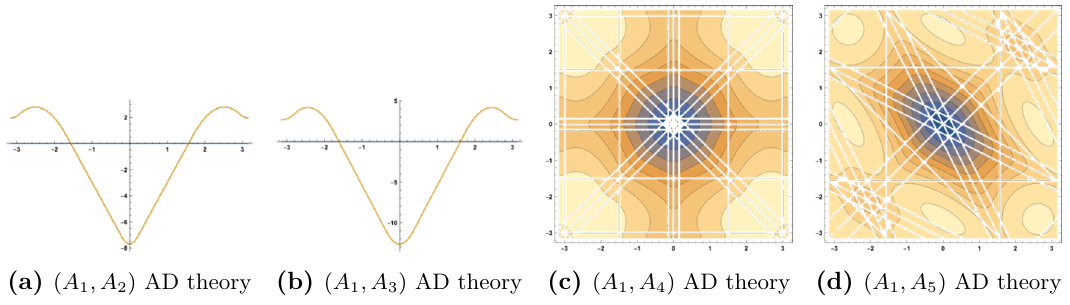
Figure 6. Im F| ∆= − iπ for ( A 1 , A N ) Agyres-Douglas theory with N ≤ 5